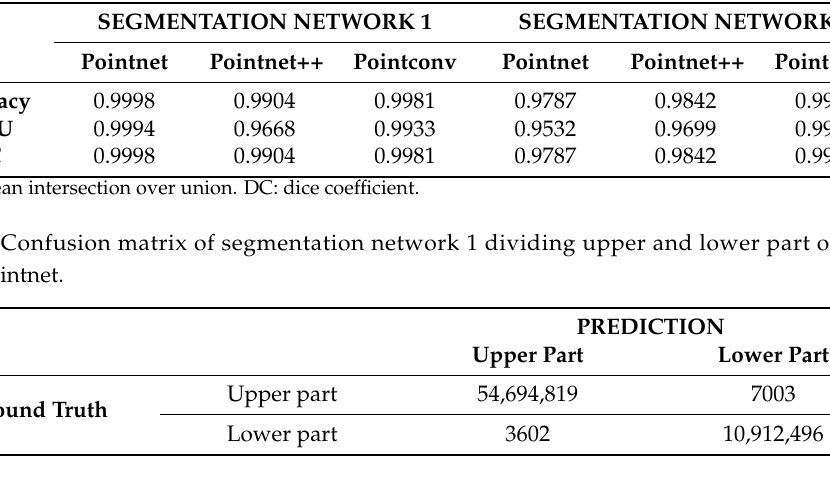
Table 3. Confusion matrix of segmentation network 2 dividing lower part of skull using